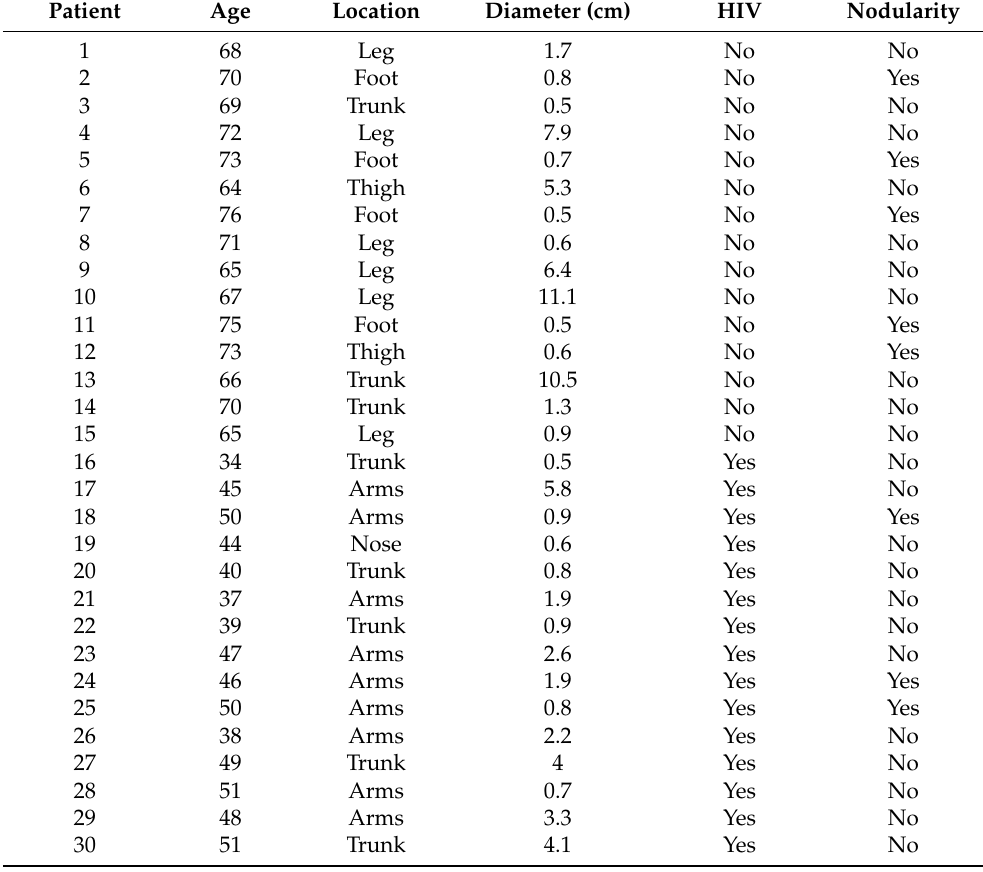
Table 1. Patient